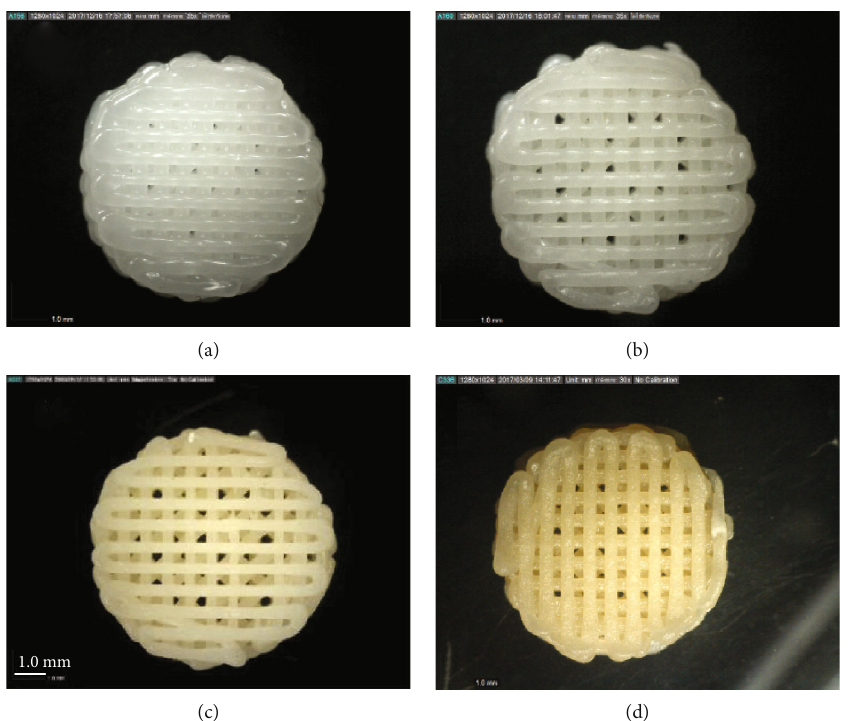
Figure 4: Sca ff olds fabricated from the ratios of blending at (a) 100/0, (b) 75/25, (c) 50/50, and (d) 25/75 PCL/PHBV using a fi lament feeding speed of 0.5 mm/s and a hatch speed of